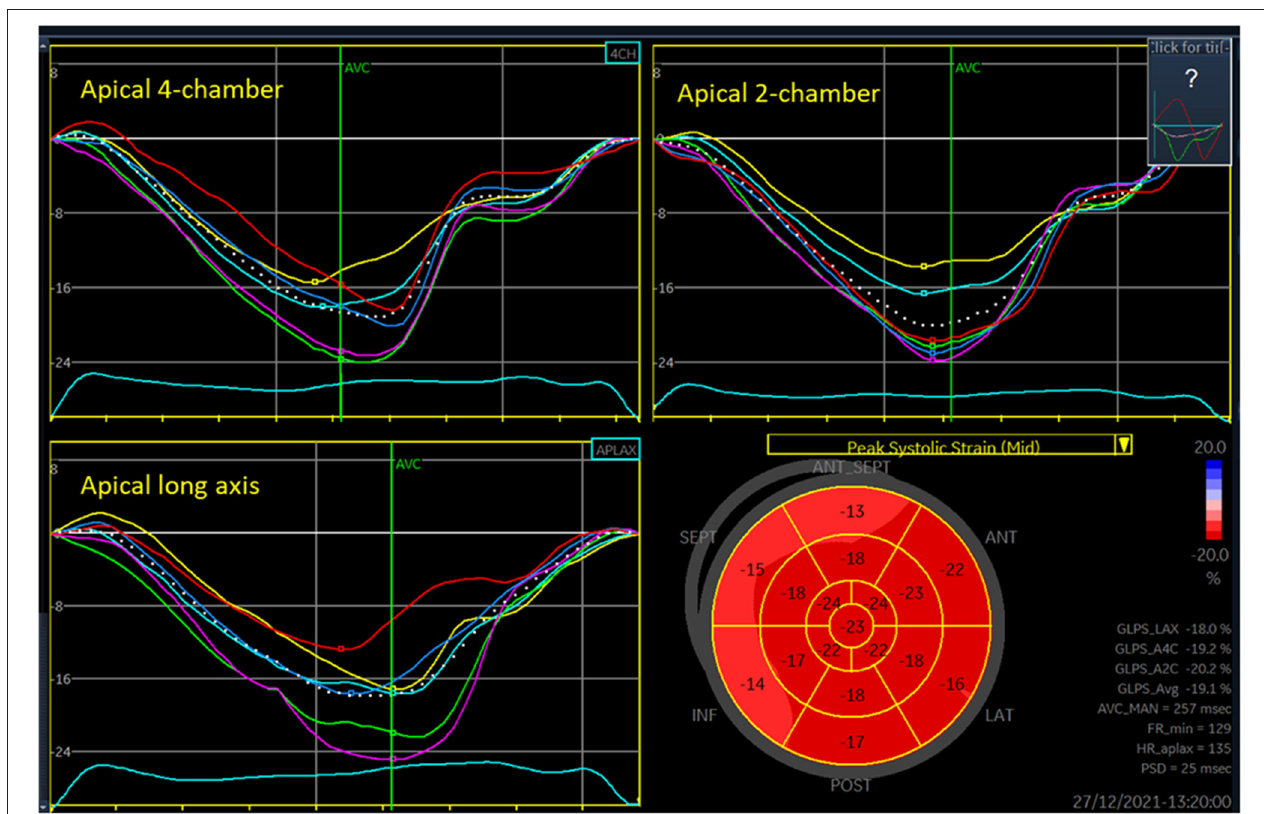
FIGURE 1 | Three-plane longitudinal strain analysis of the left ventricle. Each of the panels for the three views shows seven curves, one colored curve from each of the six segments analyzed in each view and a white dotted curve for the entire region of interest. The low right panel shows values for each segment in a 17-segment plot, with basal segments at the outer edge and apical segments at the center of the figure (“bullseye plot”). The peak of each of the dotted curves is denoted GLPS (global longitudinal peak strain) for LAX (long axis), A4C (apical four-chamber), and A2C (apical two-chamber) views. The GLPS_Avg is the average of these three peaks, often referred as the global longitudinal strain. FR_min is the lowest grayscale frame rate (Hz) among the three views analyzed. HR_aplax is the heart rate in the apical long axis recording (beats per minute). PSD is the standard deviation of the time from onset of systole to segmental peak strain for each of the segments, often denoted as mechanical